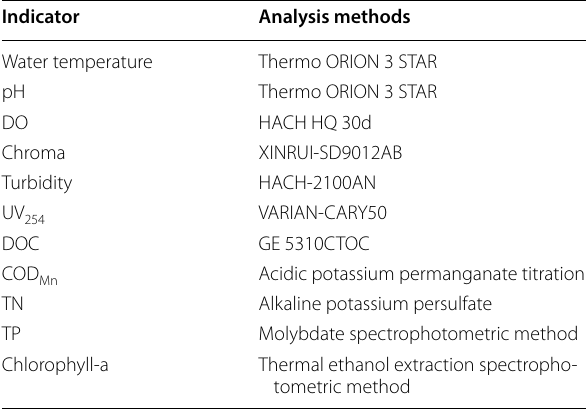
Table 1 Physio-chemical indicators and analysis